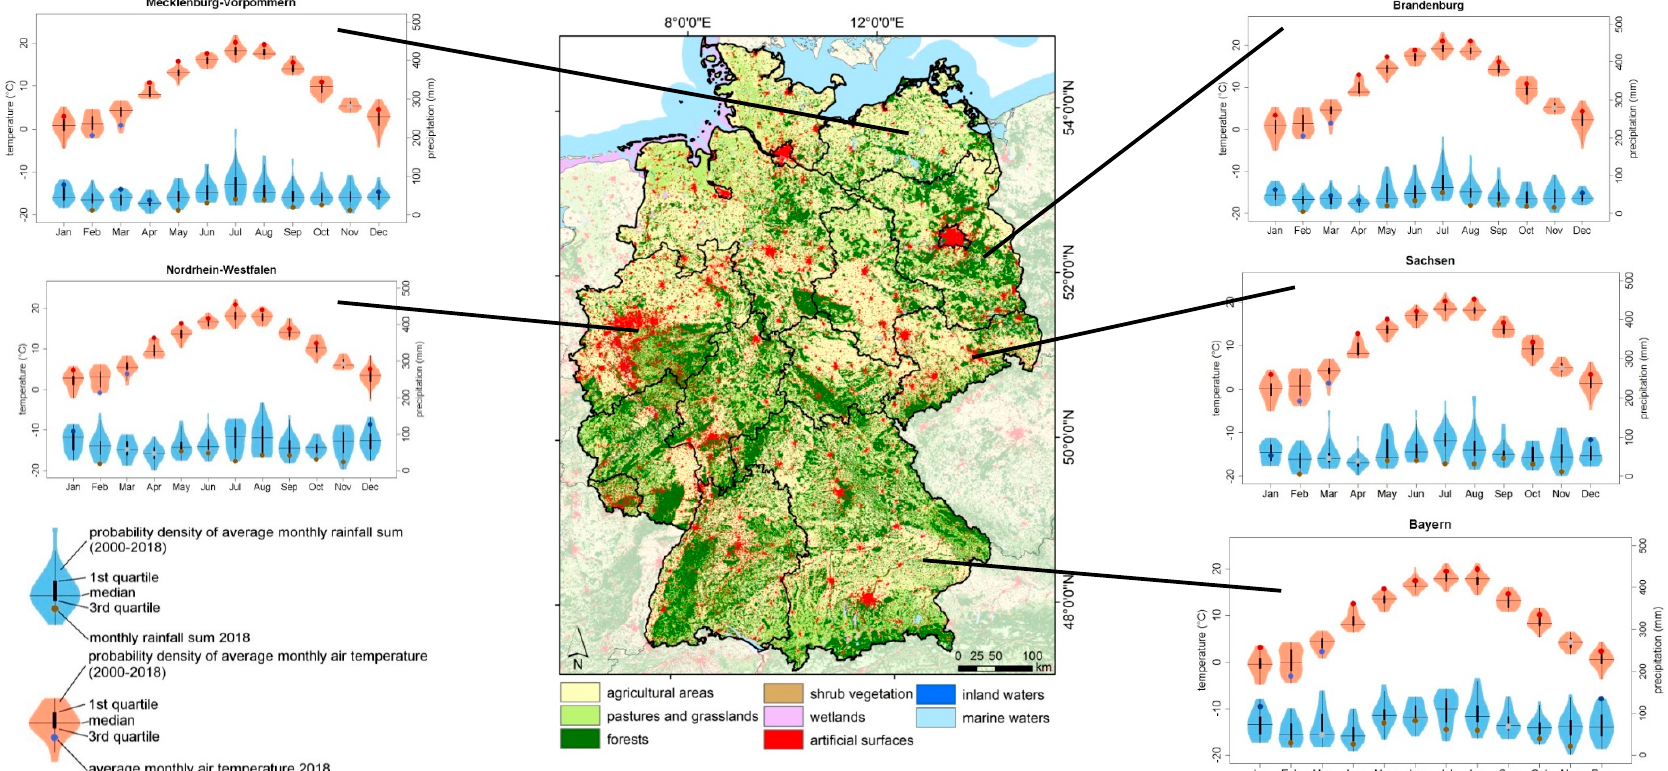
Figure 1. Land use / cover types of Germany (central panel) and annual distribution of temperature and precipitation for selected German federal states (right and left panel). Data source: land use / cover data: CORINE land cover 2012 [32]; climate data: [30].